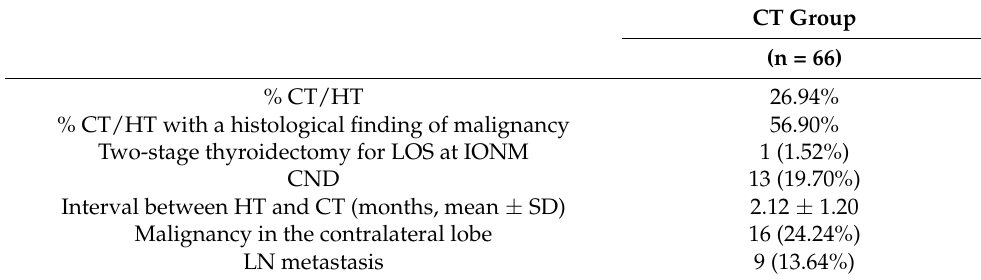
Table 3. General information about CT